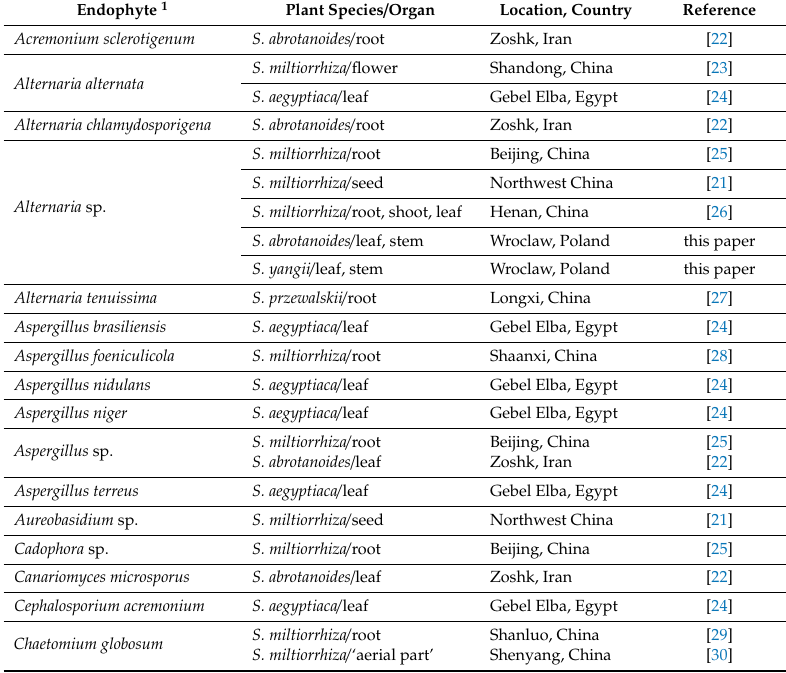
Table 1. Endophytic fungi reported from Salvia